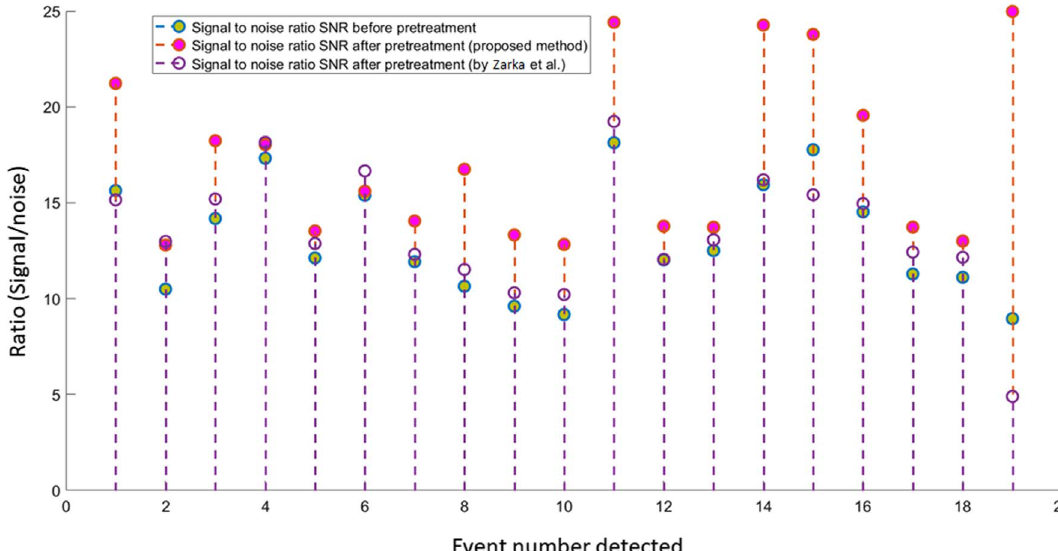
Fig. 10. SNR before and after pretreatment of the data recorded on 2 April